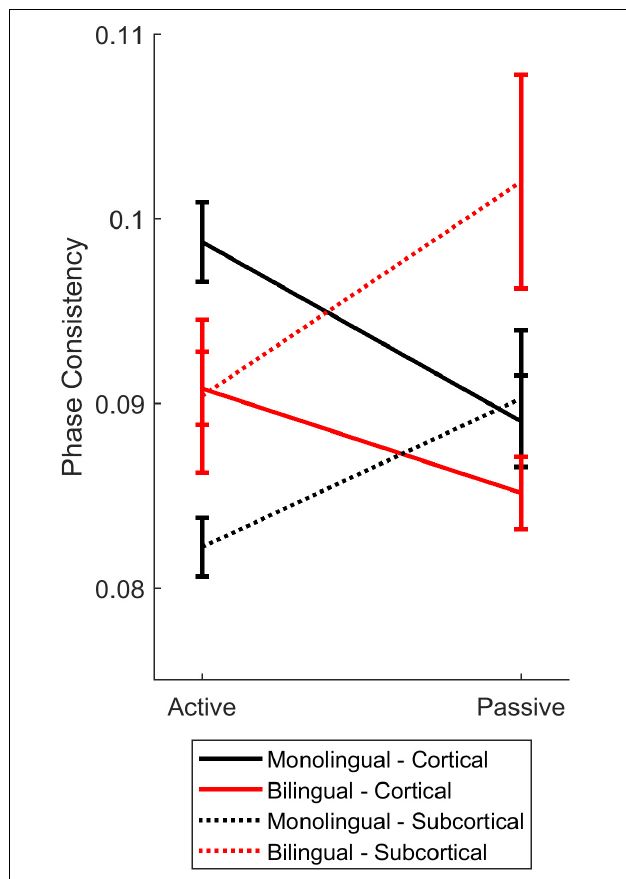
FIGURE 7 | Cortical-subcortical comparisons in bilinguals and monolinguals. Differences in levels of cortical (solid lines) and subcortical (dashed lines) consistency for monolinguals (black) and bilinguals (red) during active (left) and passive (right) listening.